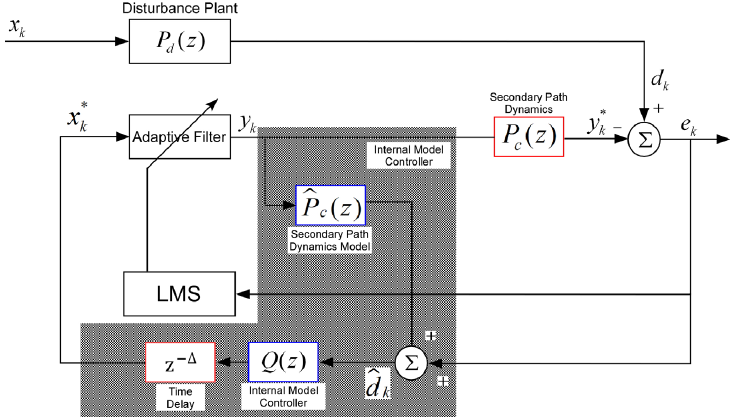
Figure 7. Schematic of a novel digital filter system with ‘recursive’ LMS algorithm, based on internal model control (IM-LMS 2).